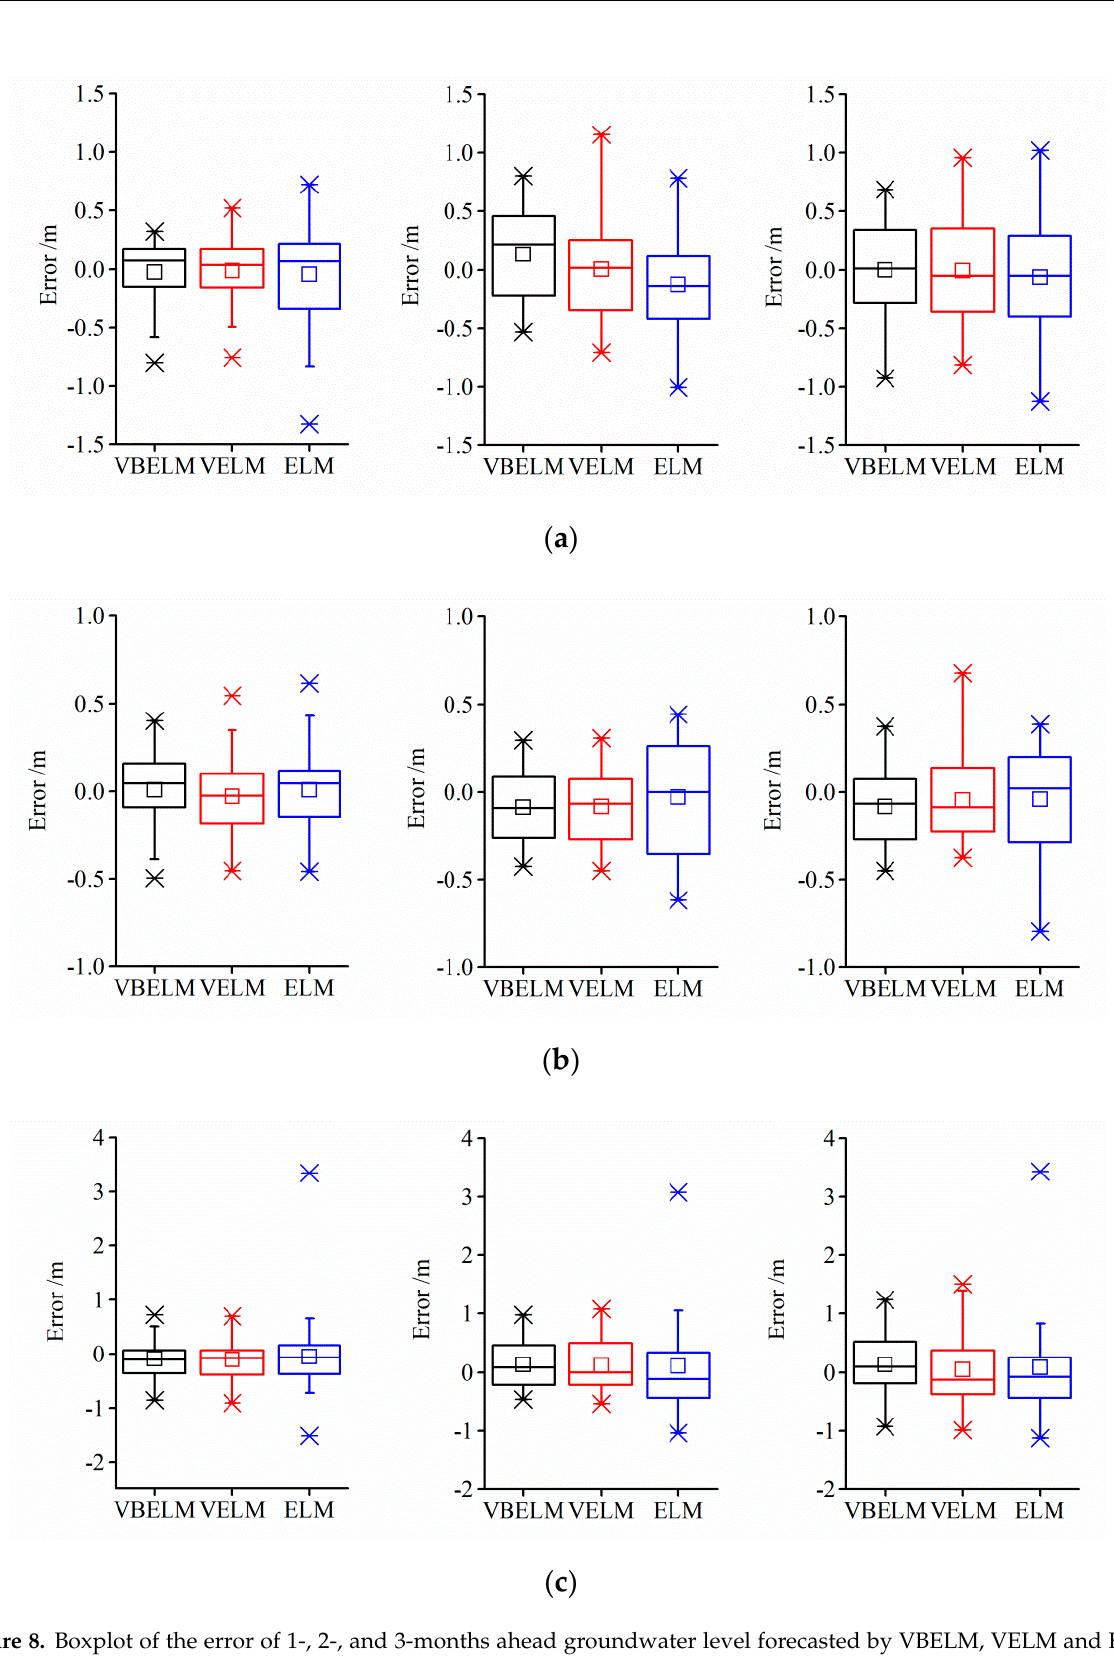
Figure 8. Boxplot of the error of 1-, 2-, and 3-months ahead groundwater level forecasted by VBELM, VELM and ELM models during the testing period at Well I ( a ), Well II ( b ) and Well III ( c ).